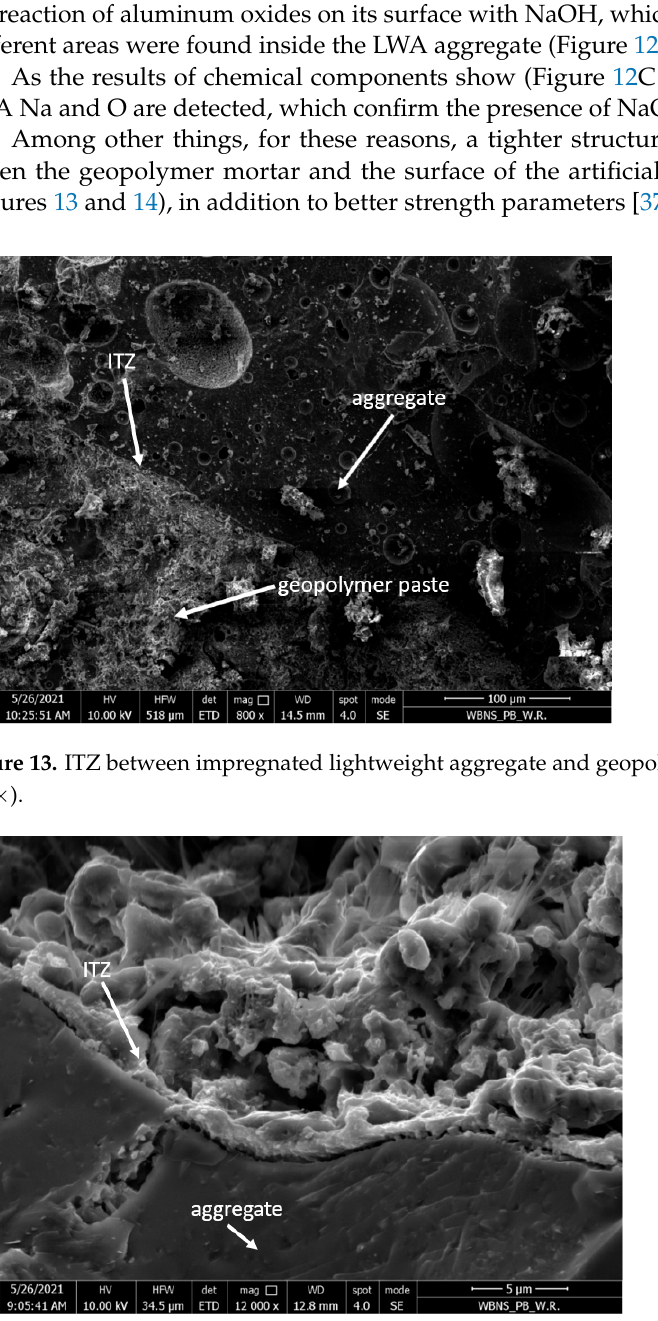
Figure 14. ITZ between the impregnated aggregate and the geopolymeric paste (magnification 12,000 ×